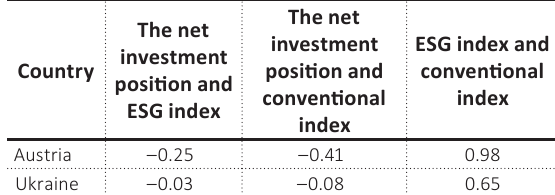
Table 1. Descriptive statistics of conventional and ESG indices: the case of Ukraine and Austria